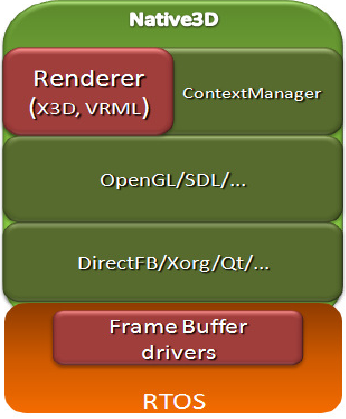
Figure 6. Inclusion of JSR 239 (Java Bind for OpenGL ES) in